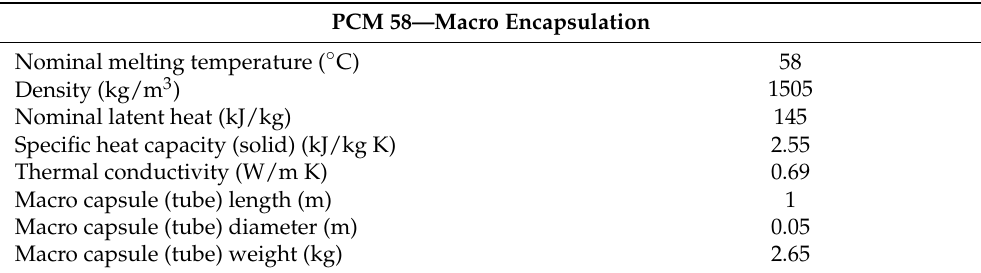
Table 1. Main features of the commercial macro-encapsulated PCM